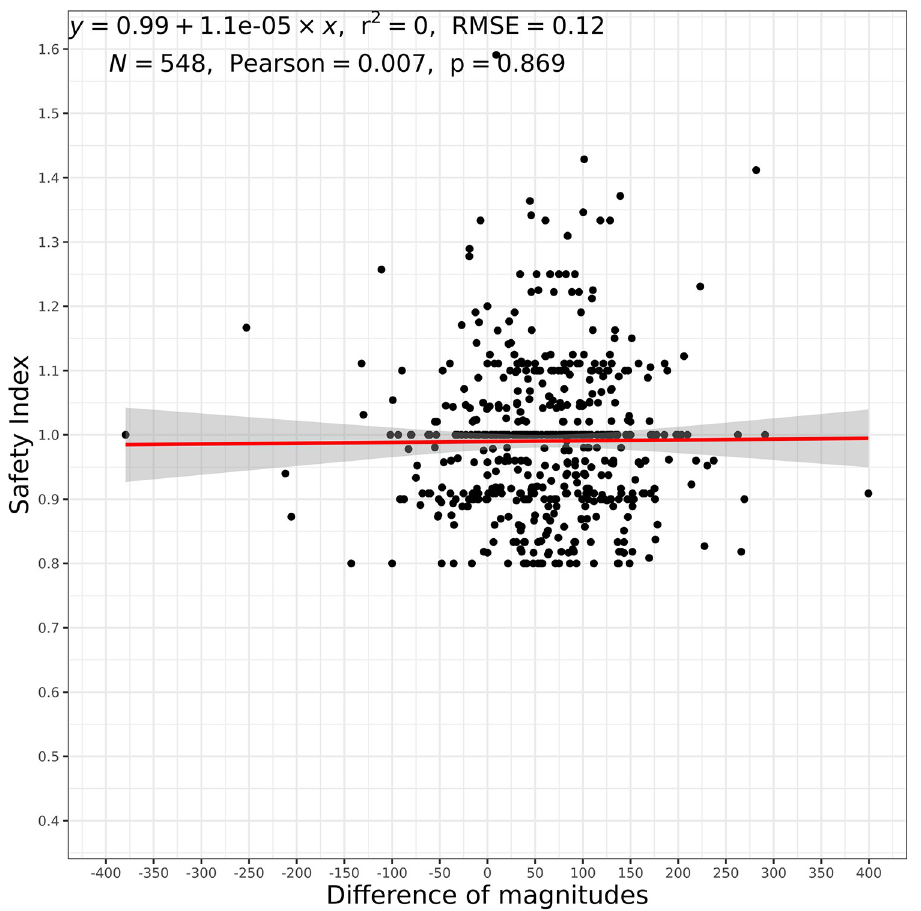
Fig 5. Difference in angle κ magnitudes in relation to SI (overall group). r 2 : coefficient of determination, RMSE: root mean squared error, N: number of eyes, Pearson: Pearson Correlation Coefficient.